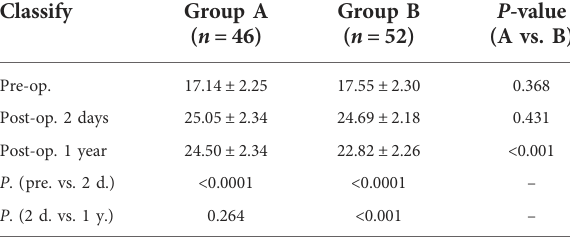
TABLE 3 Cobb angles (mean±SD;